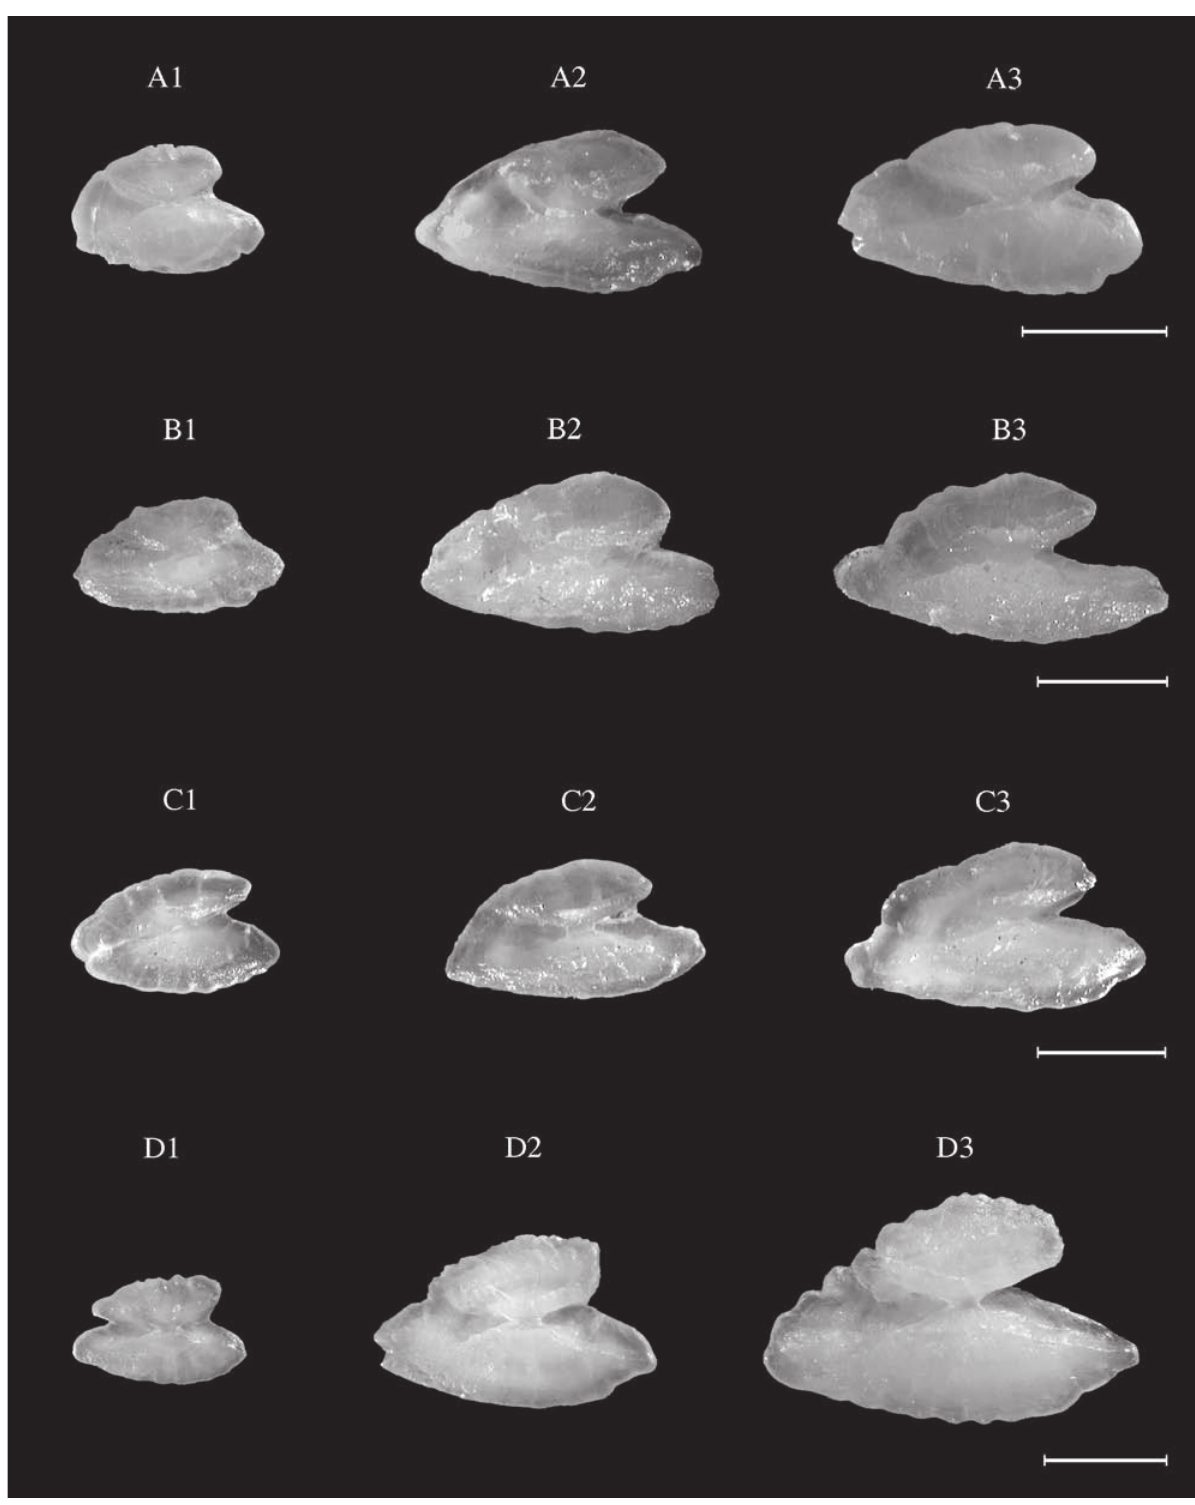
Fig. 70. – Symphodus cinereus . TL: A1, 6.6 cm (NEA); A2, 8.5 cm (WM); A3, 12.0 cm (NEA). Symphodus doderleini (WM). TL: B1, 7.0 cm; B2, 9.0 cm; B3, 9.5 cm. Symphodus mediterraneus (WM). TL: C1, 8.0 cm; C2, 9.0 cm; C3, 11.0 cm. Symphodus melops (NEA). TL: D1, 8.0 cm; D2, 17.2 cm; D3, 22.3 cm. Scale bar = 1